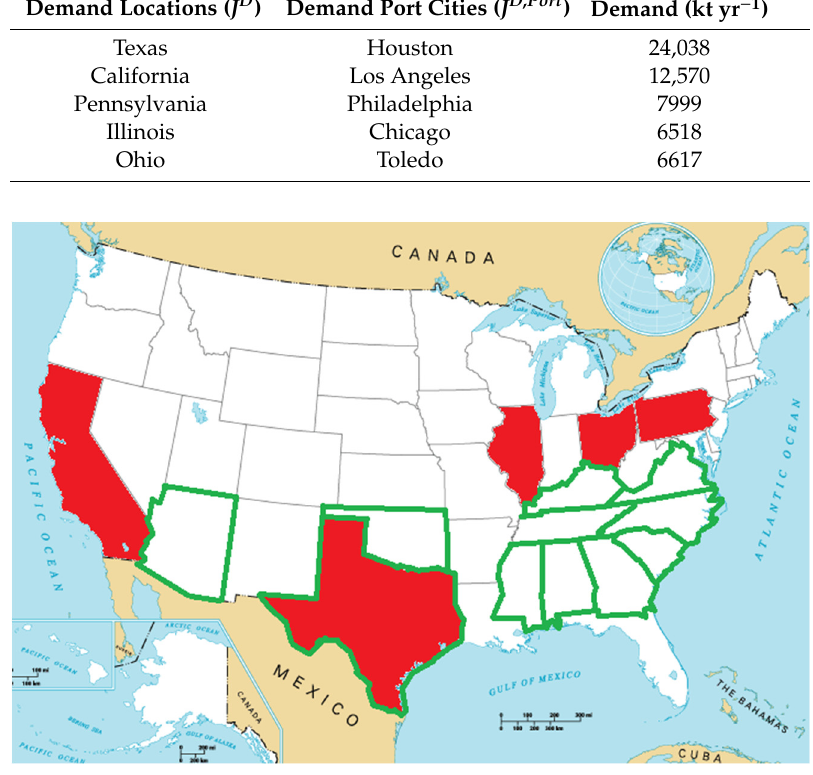
Figure 10. Supply states (outlined in green) and demand states (filled in red) as considered for the United States case of the algal biomass to biodiesel problem. Table 3. Supply locations for the United States case of the algal biomass to biodiesel problem.